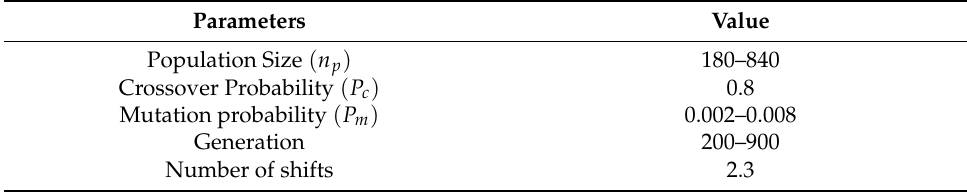
Table 3. GA input parameters.